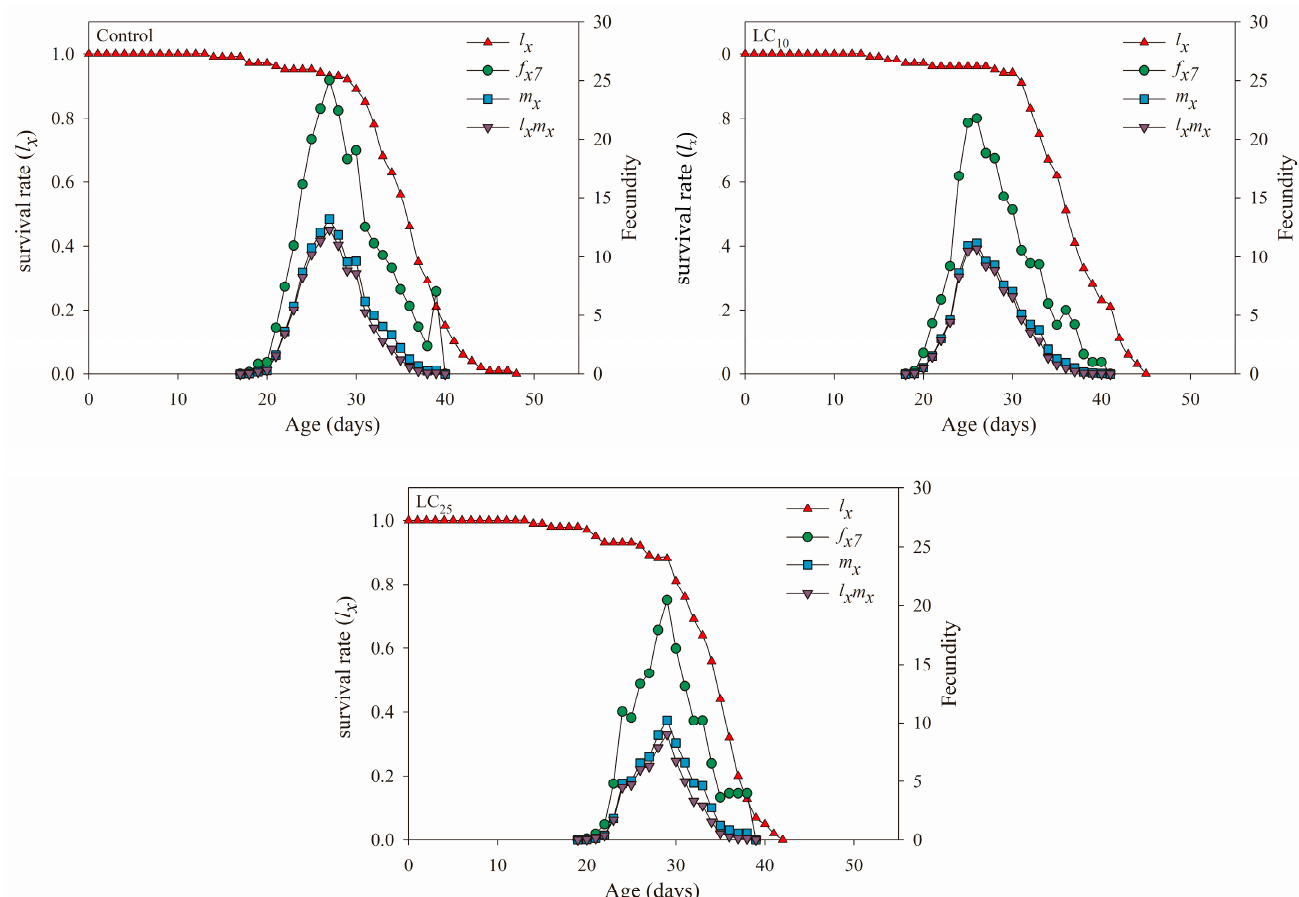
Figure 2. Age-specific survival rate ( l x ), female age-specific fecundity ( f x 7 ), age-specific fecundity of the total population ( m x ) and age-specific maternity ( l x m x ) in the control, Beauveria bassiana LC 10 - and LC 25 -treated F 1 generation of Sogatella furcifera .